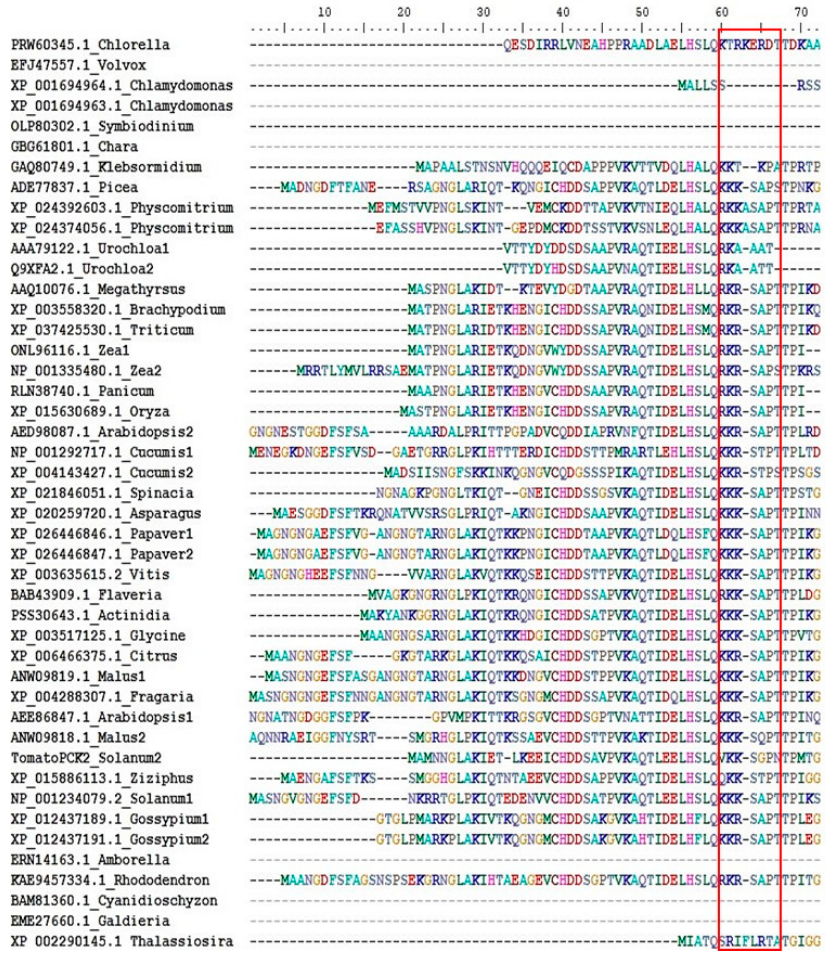
Figure 6. Alignment of N-terminal extension sequences of plant PEPCKs. Several representative PEPCK protein sequences, from the phylum of plants and algae [134], were selected from the NCBI database. Protein sequences were aligned using Clustal W [135]. The alignment of N-terminal extension sequences was edited and extracted using the BioEdit programme. Species names are listed by the side of accession number. The phosphorylation motif (KK/RXSXPT) or its absence is shown in the red box.